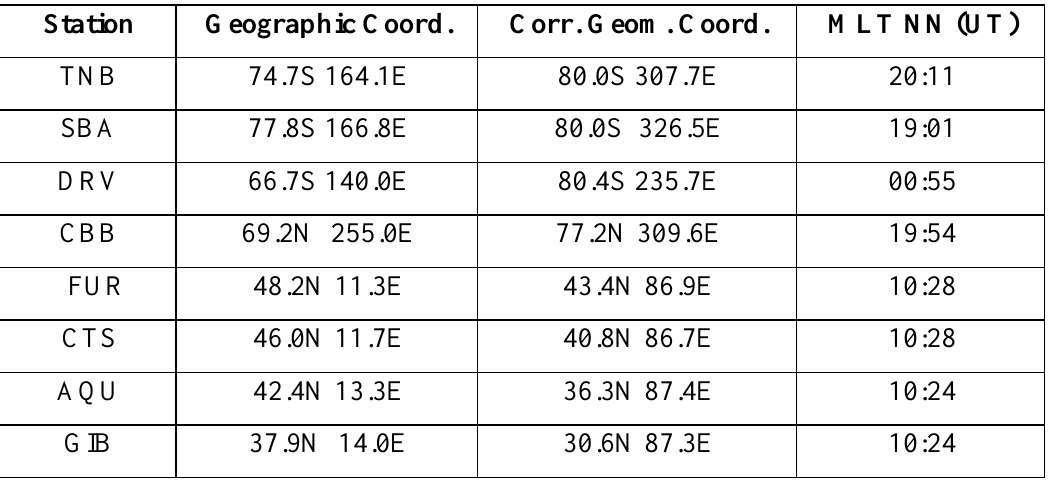
Table 1. Geographic coordinates, IGRF2003 corrected geomagnetic coordinates and time in UT of the magnetic local noon for the